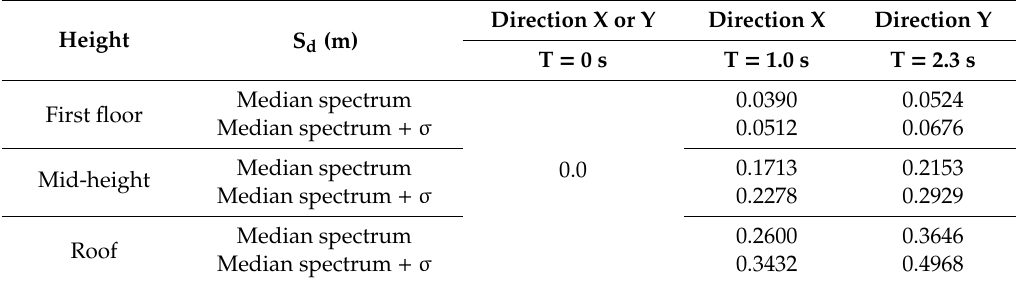
Table 5. Spectral relative displacement values for RP = 200 years for three periods of interest. Height S d